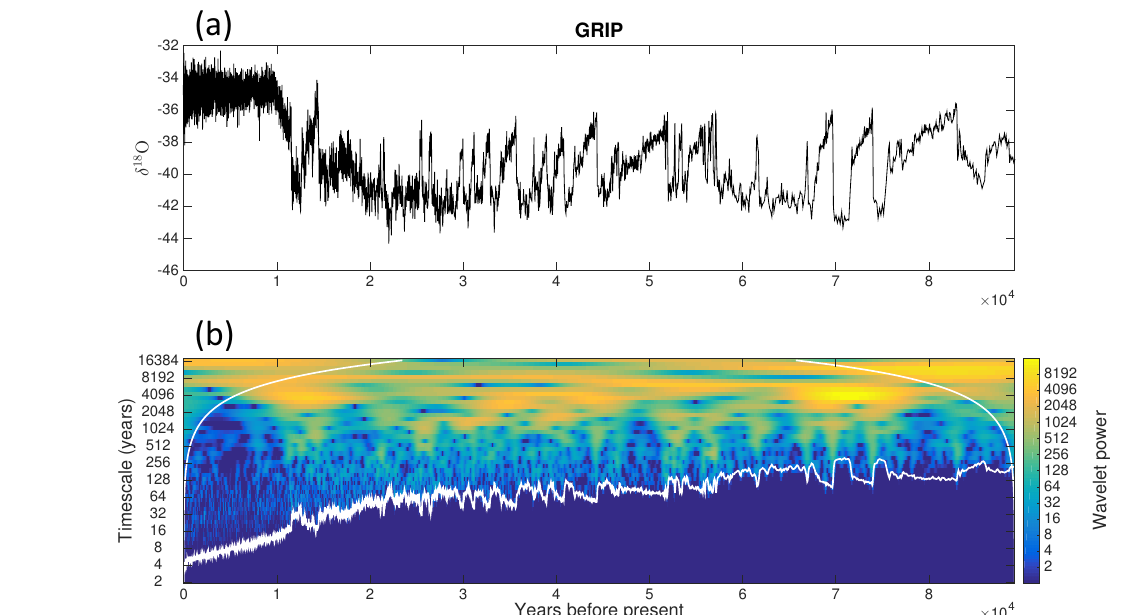
Figure 16. Top panel: the δ 18 O proxy time series for Greenland temperature from the GRIP ice core for the period 0–90kyrBP. Bottom panel: the Morlet wavelet scalogram for the signal in the upper